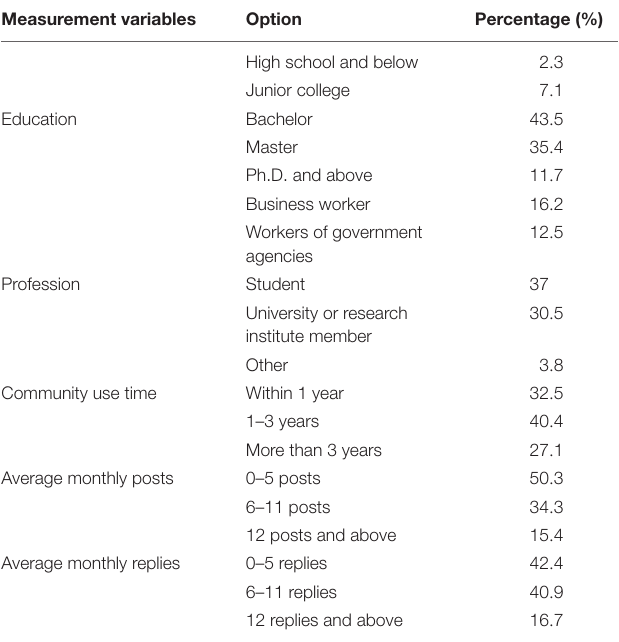
TABLE 1 | Basic information of virtual community users. Measurement variables